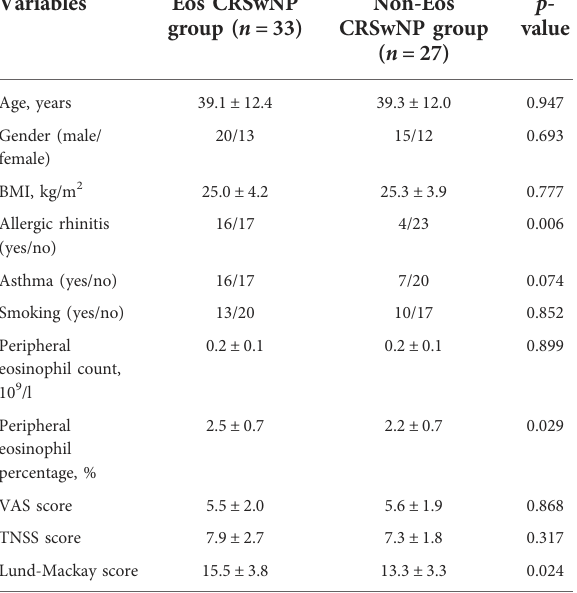
TABLE 2 The demographic and clinical parameters between Eos and non-Eos CRSwNP group.